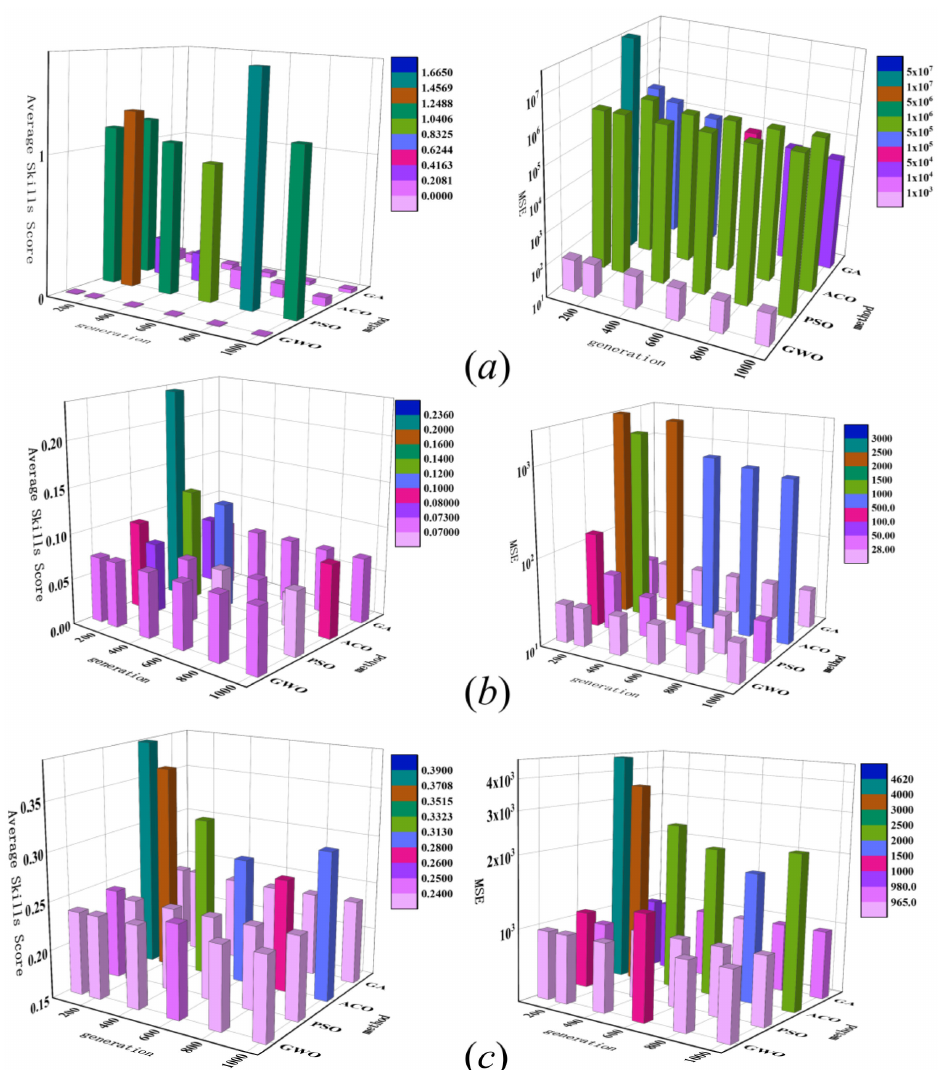
Figure 6. Comparison results of different optimization algorithms with different iterations numbers in ( a ) simulation case, ( b ) run 17 and ( c ) run